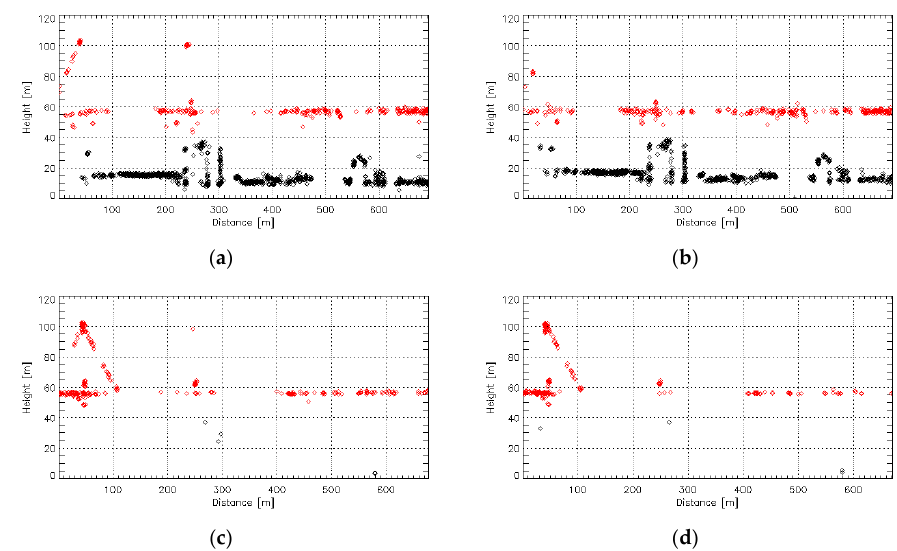
Figure 10. Plots of the estimated height of the coherent pixels located within the red rectangle in Figure 9 for the ( a ) SBAS and ( b ) TomoSAR processing results related to the ascending dataset, and ( c ) SBAS and ( d ) TomoSAR results relevant to the descending dataset. Red and black squares correspond to measurement points located at the roadway, pillars and cables and at the ground level, respectively. Horizontal axis corresponds to the longitudinal distance from the origin of the red rectangle located at its southern/eastern end, as reported by the white graduated scale in Figure 9. Remote Sens. 2020 , 12 , x FOR PEER REVIEW